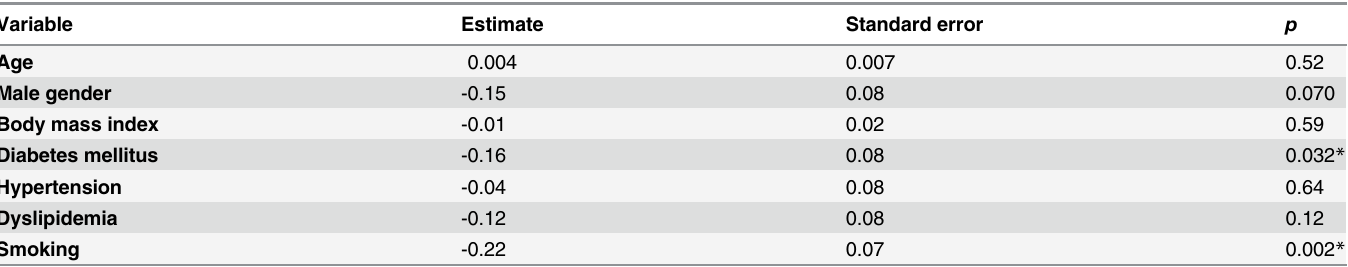
diseased vessels, SYNTAX score and the type of CAD at presentation. By coronary angiogra- phy, 34 (20%) CAD patients had single-vessel disease, 60 (36%) had double-vessel disease and Table 2. Univariate linear regression analysis for plasma levels of Ln_miRNA-145.